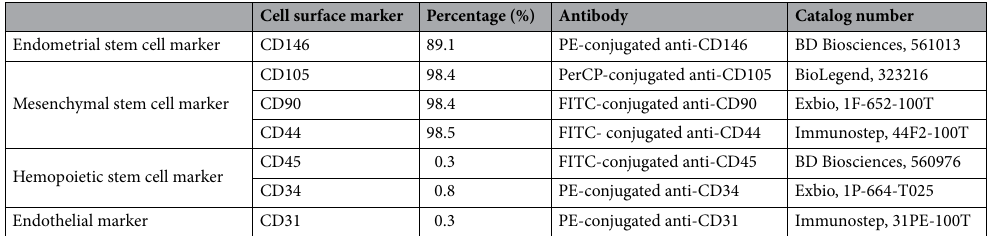
Table 1. Markers for hEnSCs identification. PE phycoerythrin, PerCP peridinin chlorophyll protein, FITC fluorescein